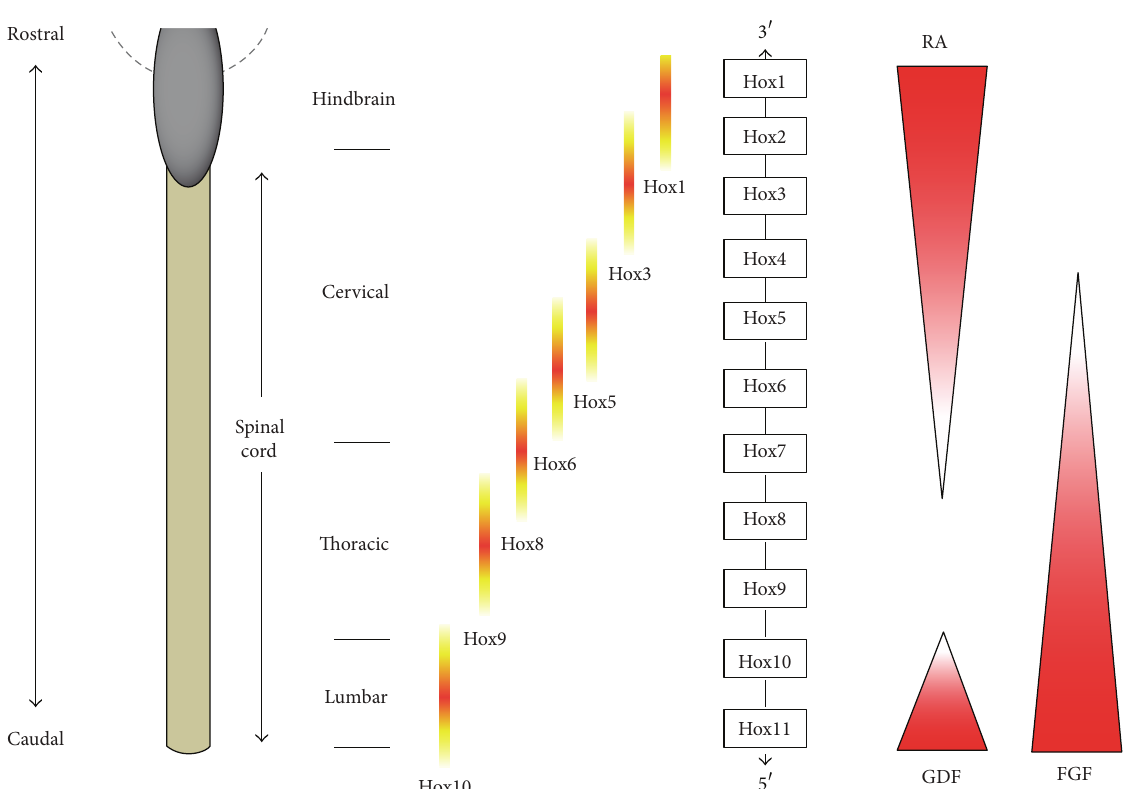
Figure 2: A schematic depicting expression patterns of chromosomally linked Hox genes along the rostrocaudal axis. Hox genes at one end of the cluster are expressed more rostrally, while those at the opposite end are expressed caudally. As indicated, RA is responsible for rostral spinal cord patterning (i.e., the cervical spinal cord). Caudal spinal areas are patterned by FGFs and GDFs. The precise nature of how these caudalizing factors conspire with one another has yet to be resolved. RA: retinoic acid; FGF: fibroblast growth factor; GDF: growth/differentiation